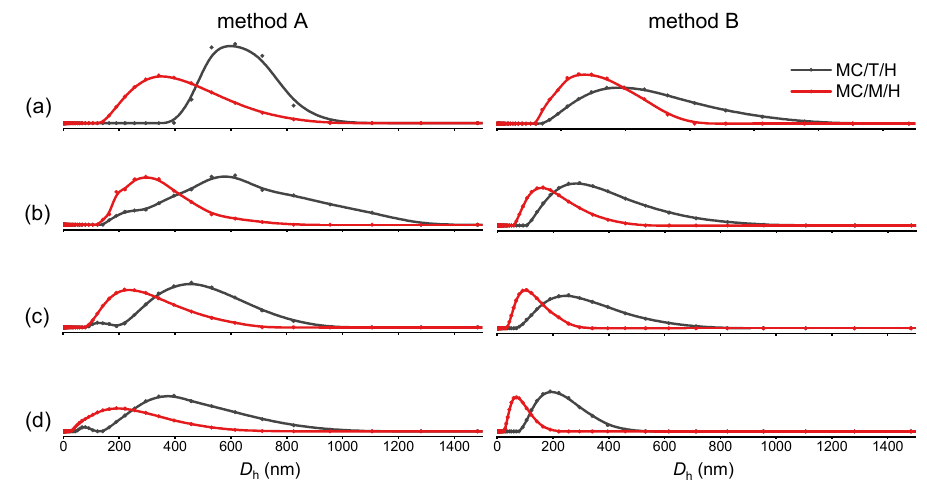
Figure 3. Hydrodynamic diameter distributions of multiple-crosslinked nanogels prepared with the method A and B. The concentrations of TPP or Na 2 MoO 4 were 0.20 ( a ), 0.10 ( b ), 0.05 ( c ), 0.04 ( d ) mg mL − 1 , respectively.